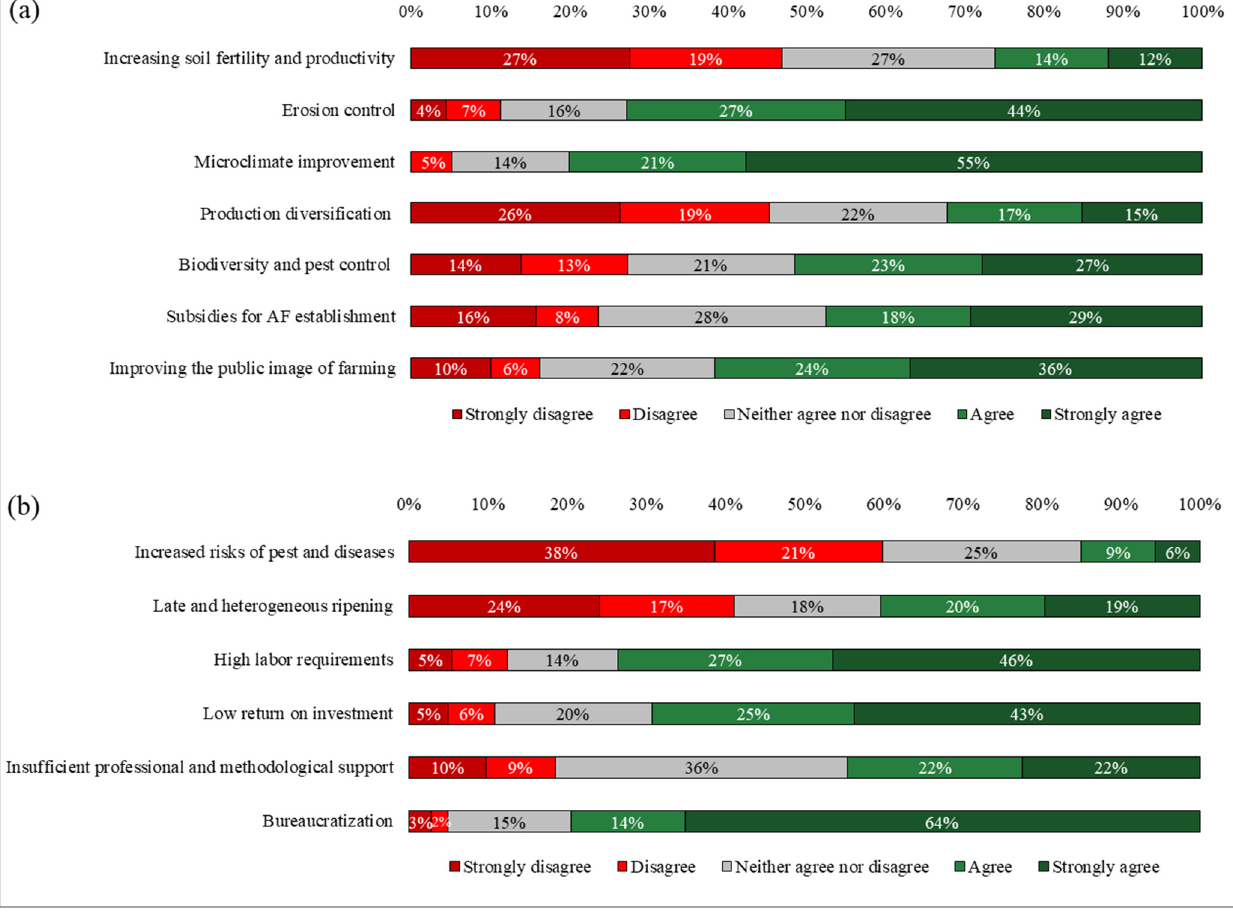
Figure 4. Farmers’ ( a ) expectations from and ( b ) concerns of the establishment of